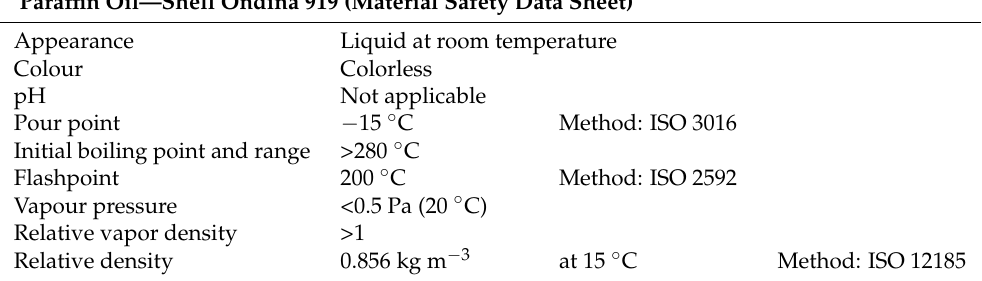
Table 2. Quench fluid properties.